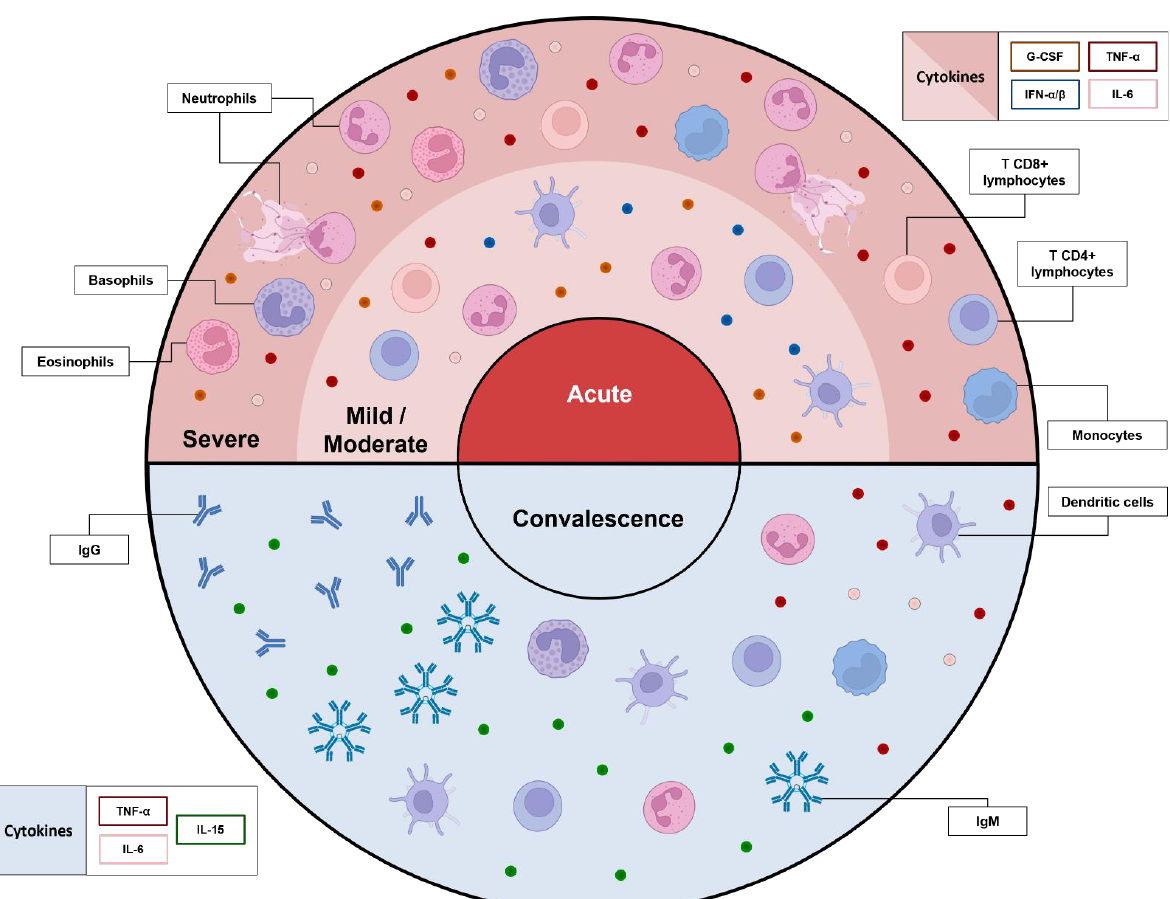
Figure 2. Transient immunological response in mild/moderate, severe, and convalescent patients with cellular and molecular profile. Severe patients experience intensive immune dynamics, driven by cytokine storm (TNF- α, IL -6, IFN- γ, and CCL2), which may worsen clinical condition, as well as compromise adaptive immunity. With clinical improvement, the Th2 profile becomes more prominent, with participation of IL-10, IL-2, IL-4, IL-13, IL-15, IL-18, CCL3, CCL4, and CCL2; however, if a Th1 profile persists, a poor outcome can be seen. Those with a mild/moderate profile have more antiviral properties (IFN- α and IL -15RA), with a higher proportion of T CD8 + lymphocytes, neutrophils (especially bands), and dendritic cells. Regulatory and anti-inflammatory mechanisms prevent severe conditions, but may also interfere during convalescence. This stage is marked by an improvement in monocyte count (for those severe) and a change in cytokines to a repairment profile. In convalescent patients, higher antibody IgM titers are seen during the first months after infection, while IgG may survive for years, potentiating the prevention of new infections. Adaptive cell surveillance prevails over innate immunity; however, local damage to tissues may cause further complications or even increase the risk of death.